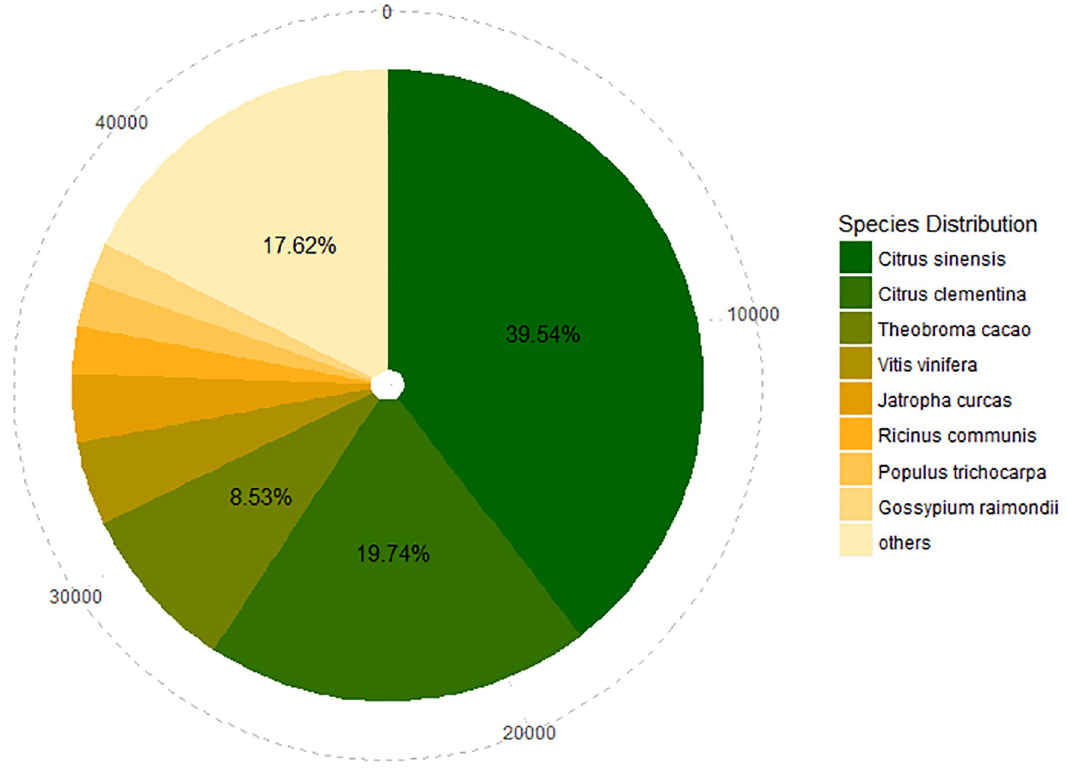
Fig 3. Species distribution of best blastx hits to NR database. Cumulative total numbers of unigenes annotated to NR were shown in the outermost circle with the dotted line. The size of the area was in proportion to the percentage of best blastx hits to the corresponding